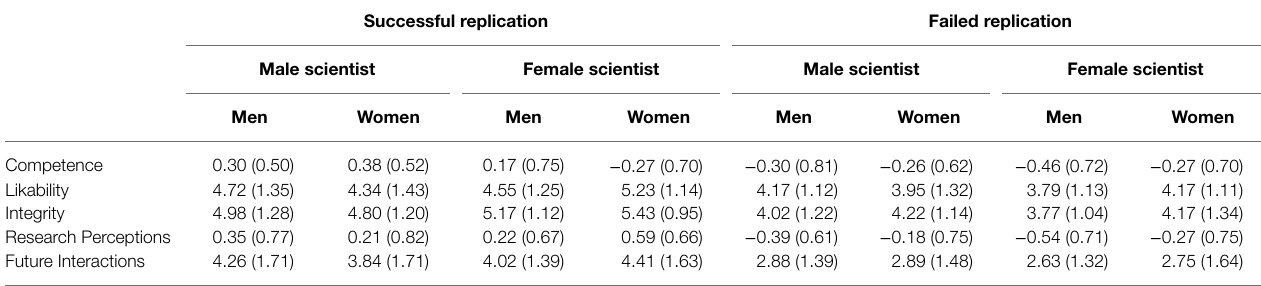
TABLE 2 | Study 1 dependent variable means and standard deviations by experimental conditions and participant